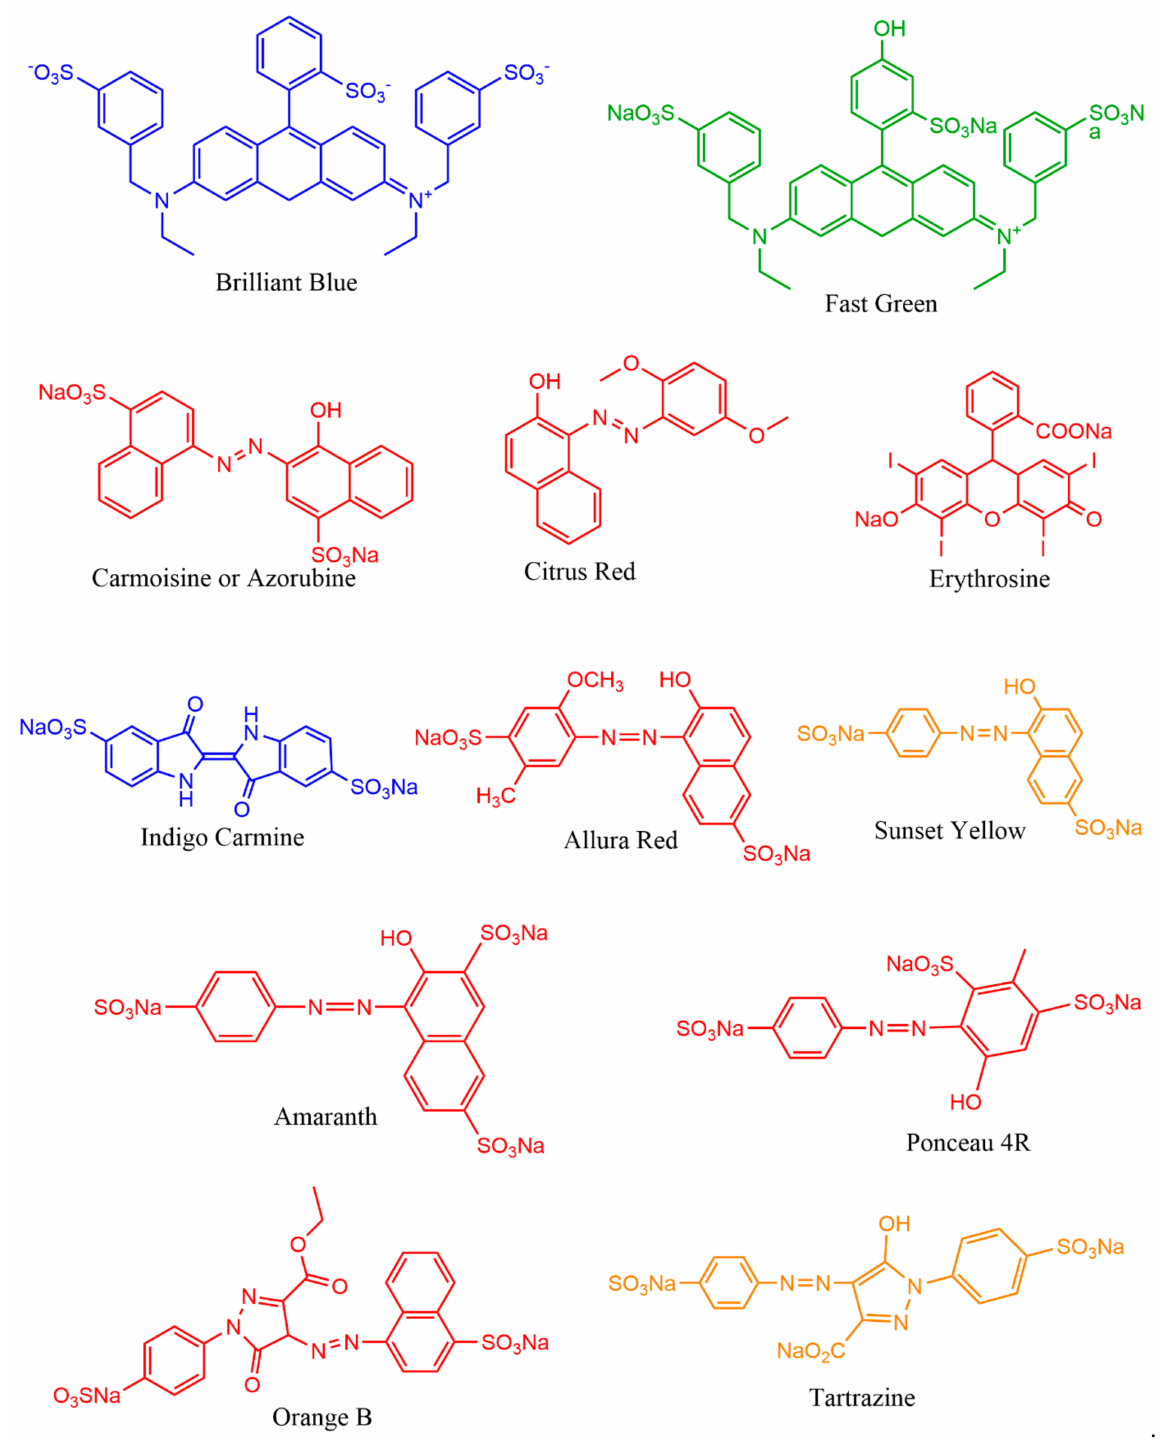
Figure 5. Chemicals structures of synthetic